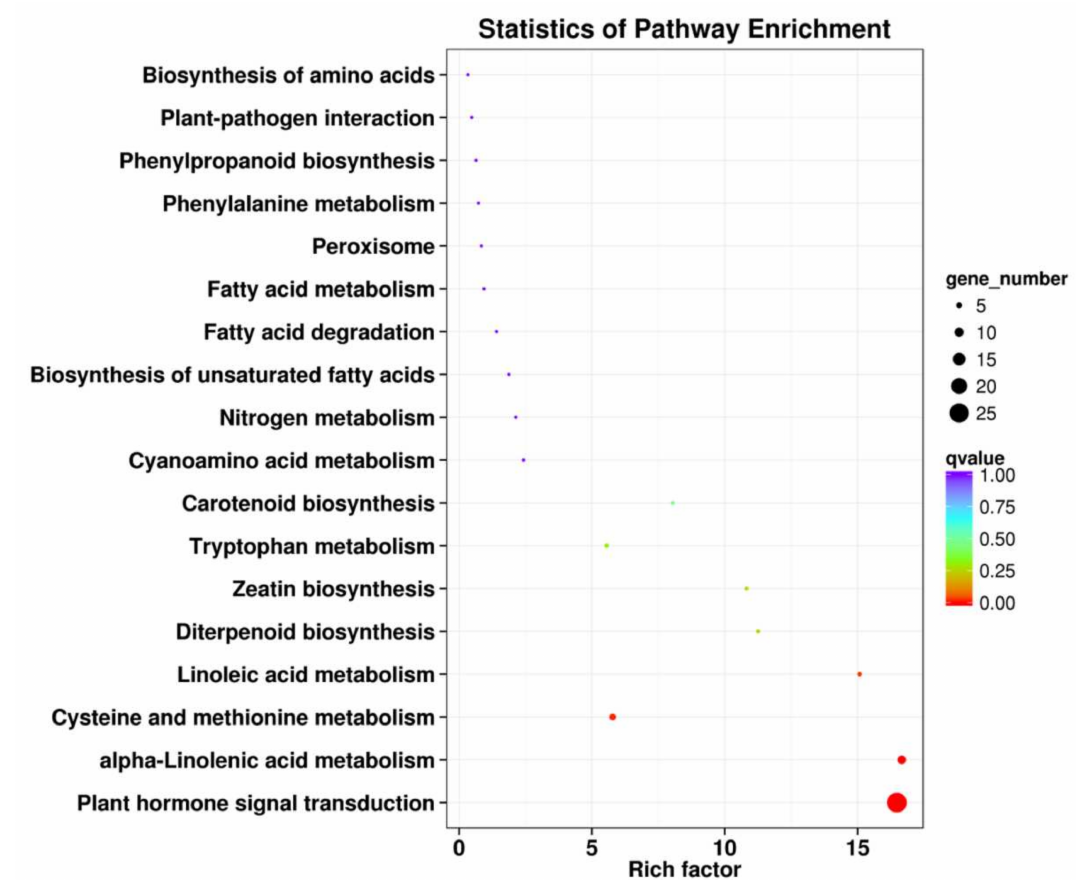
Figure 3. KEGG pathway enrichment of DEGs associated with Achnatherum inebrians under different moisture content and the status of Epichloë gansuensis endophyte. Only the top 20 most strongly represented pathways are displayed in the diagram. The q-value ranges from 0 to 1, and a q-value closer to 0 indicates greater